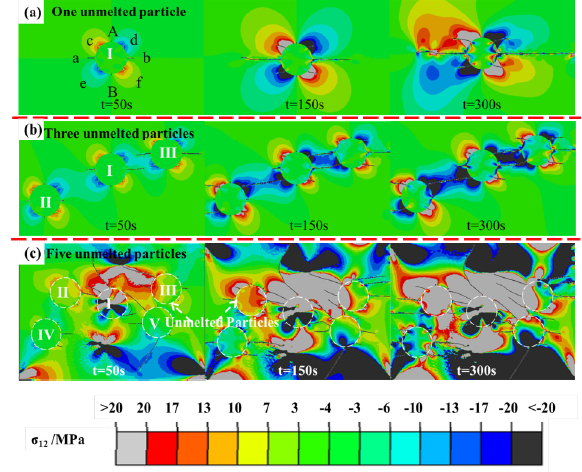
Figure 9. Crack propagation state and σ 12 stress distribution in coatings with various UNCs, ( a ) one UNPs; ( b ) three UNPs; ( c ) five UNPs.